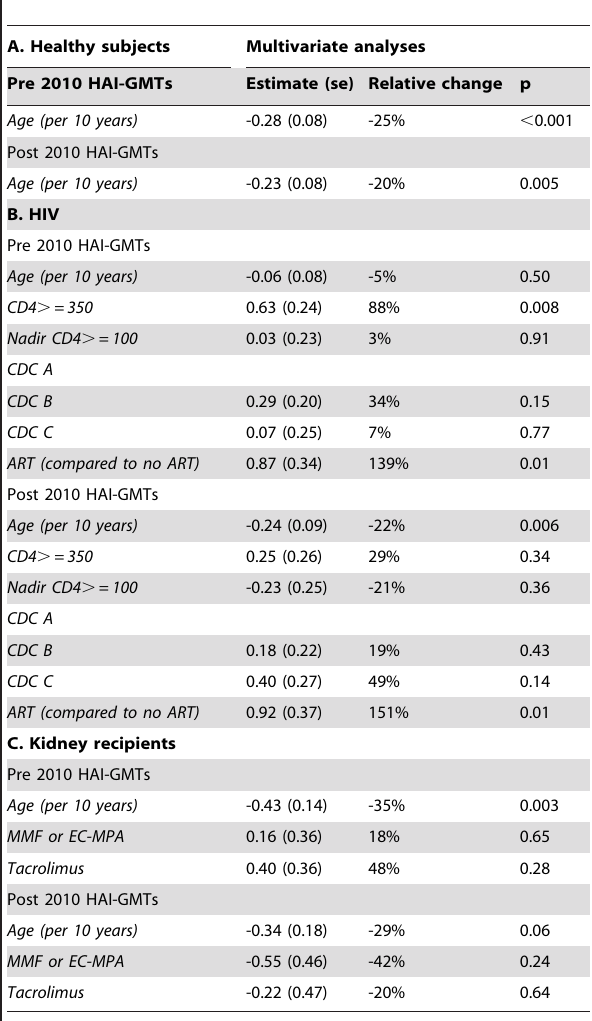
Table 4. Multivariate regression analyses of anti-influenza A/ 09/H1N1 HAI titre